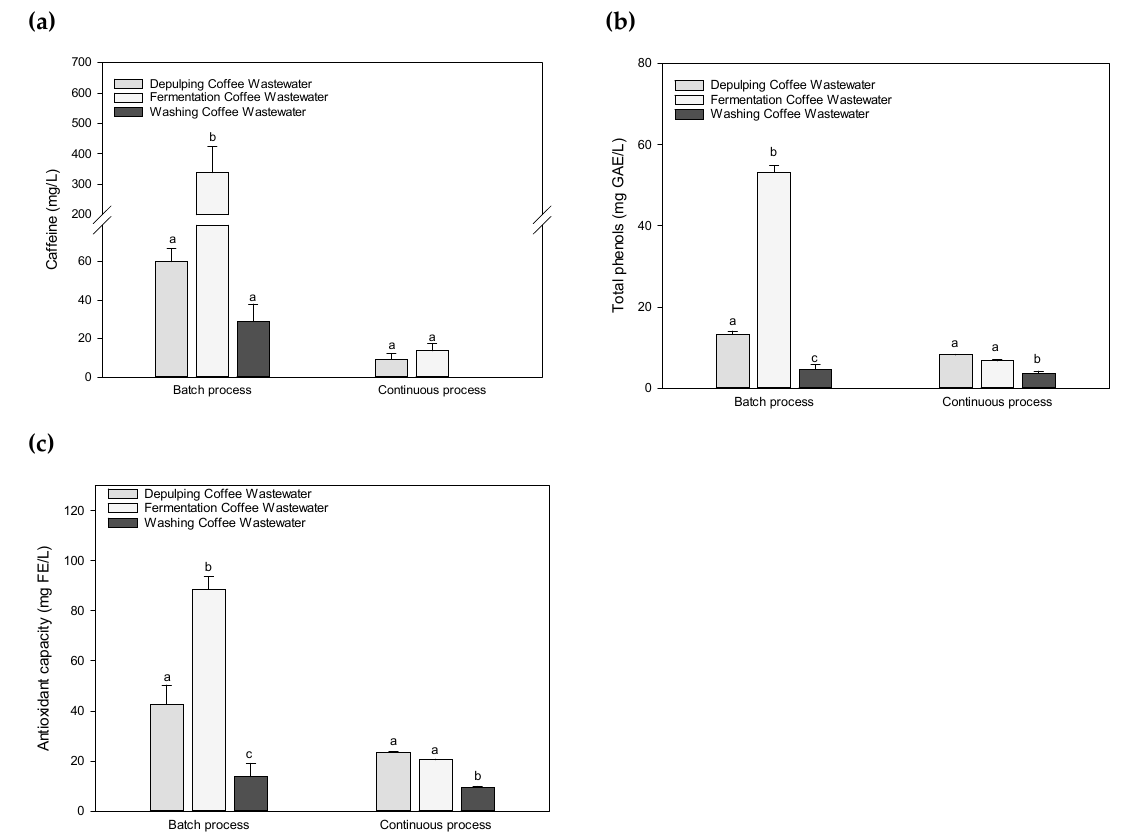
Figure 3. Amounts of ( a ) caffeine content, ( b ) total phenols and ( c ) antioxidant capacity of de-pulping coffee wastewater, fermentation coffee wastewater and washing coffee wastewater during the wet batch and continuous processing. Data are expressed as means ± standard deviation. n = 3. Different letters indicate significantly different values for each group (different superscript letters indicate a significant different, p < 0.05, ANOVA, Tukey´s test).